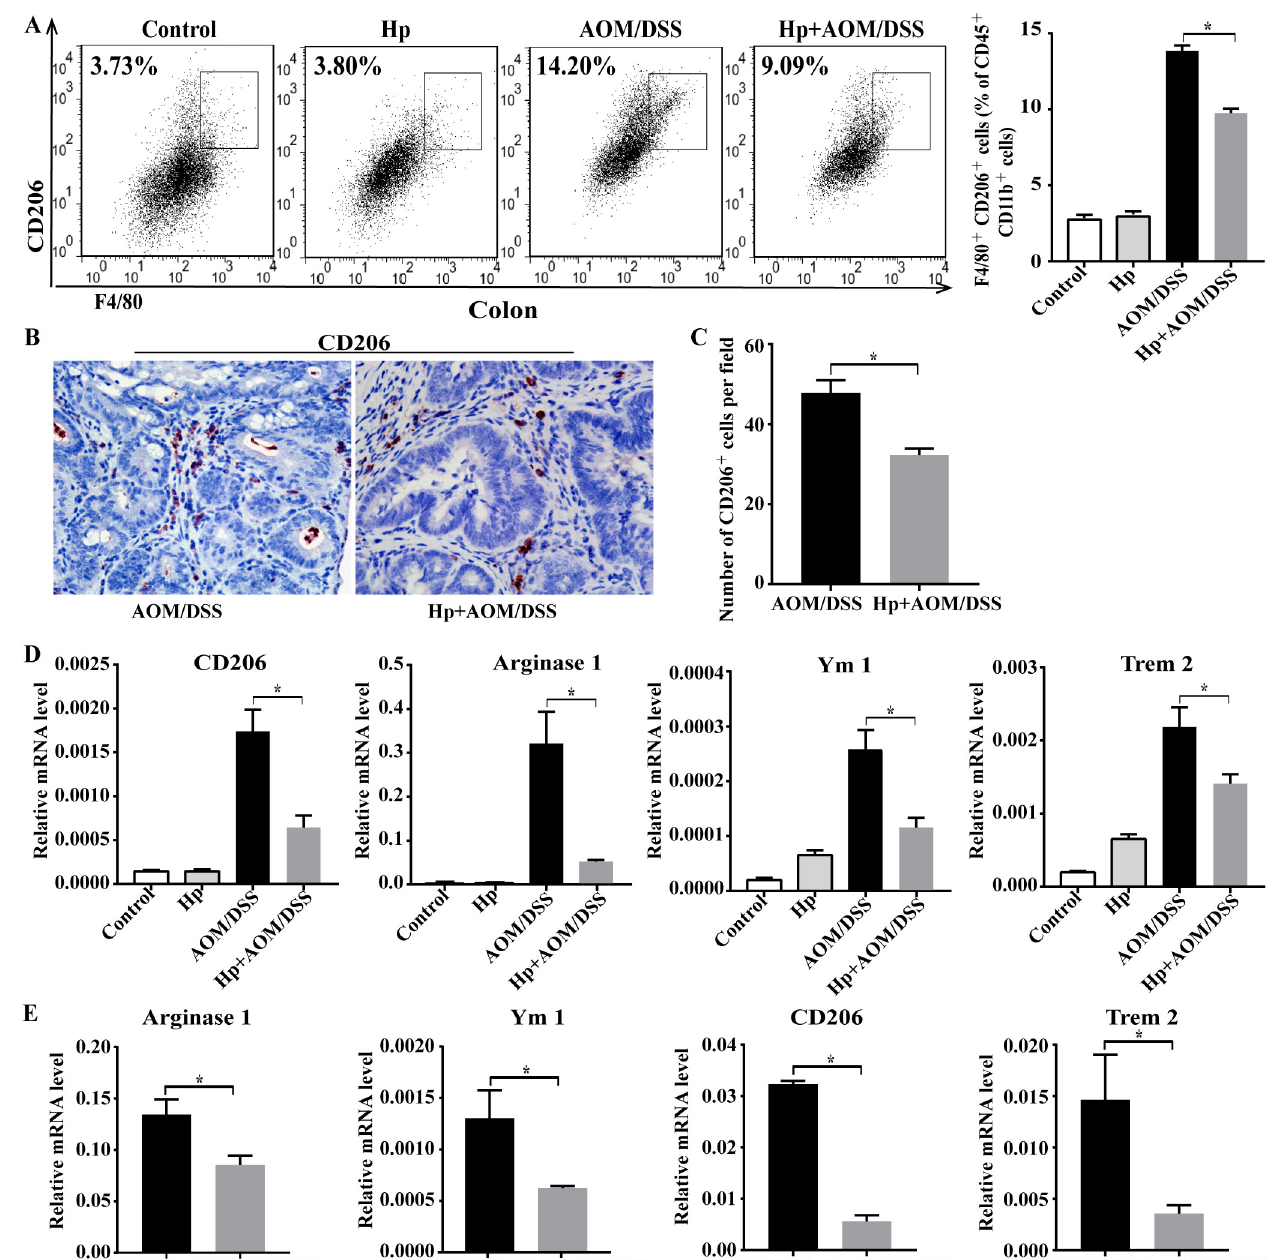
Fig 4. H . pylori infection reduced M2 macrophages proportion in CAC. (A) Flow cytometry analysis of CD45 + CD11b + F4/80 + CD206 + M2 macrophages in colonic tissues from AOM/DSS-treated group (AOM/DSS) and AOM/DSS-treated with H . pylori infection group (Hp+AOM/DSS) (n = 6/group). (B) Representative immunohistochemical images of the M2 marker CD206 staining in tumor tissues ( × 400) and (C) the numbers of CD206 + cells per field (n = 6/ group). (D) Relative mRNA expression of M2-associated genes (Arginase1, CD206, Trem2 and Ym1) in colonic tumors (n = 5-6/group). (E) Arginase1, Ym1, CD206 and Trem2 mRNA expression in F4/80 + macrophages isolated from tumors of AOM/DSS group and Hp+AOM/DSS group (n = 5-6/group). Data are represented as mean ± SEM. � P < 0.05.